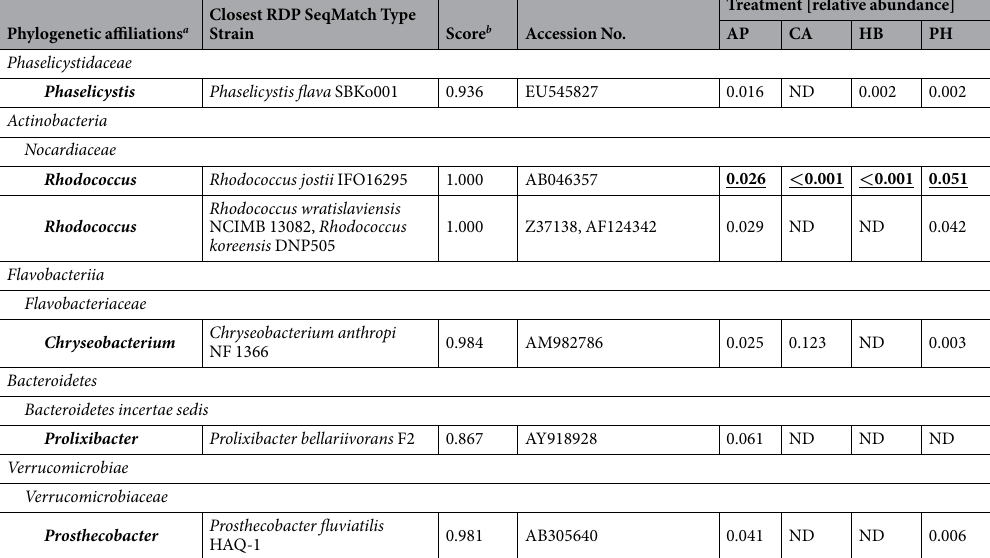
16S rRNA gene-based phylogenetic analysis revealed ubiquitous enrichment of several sequence variants affiliated with microbial taxa, which have been reported to act as degraders of many classes of environmental pollutants. These include members of the following genera: Cupriavidus , previously found to be involved in the degradation of phenolic and chloroaromatic compounds as well as toxic aromatic petroleum hydrocarbons 53 ; Rhodococcus , whose members are notorious for their biodegradation capabilities, also involving chlorinated ali- phatic hydrocarbons such as trichloroethylene and VC 54, 55 ; Sphingopyxis , with S. chilensis being reported to be capable of growing on certain chlorophenolic compounds 56 ; Sediminibacterium , whose member S. salmoneum was detected in a butane-enriched mixed microbial culture capable of aerobic cometabolic degradation of trichloroethylene 57 ; Dokdonella , detected in the aqueous phase of a model wetland supplied with cDCE- and trans- DCE-contaminated water 58 ; and Pseudomonas , whose members are known to contain di- and monooxygen- ases which can initiate cDCE oxidation upon induction of cometabolic growth on monoaromatic substrates 59, 60 . In this study, different pseudomonads were detected, including those closely related to P. fulva , P. flavescens , P. benzenivorans and P. argentinensis enriched in acetophenone, phenethyl alcohol and p -hydroxybenzoic acid cul-